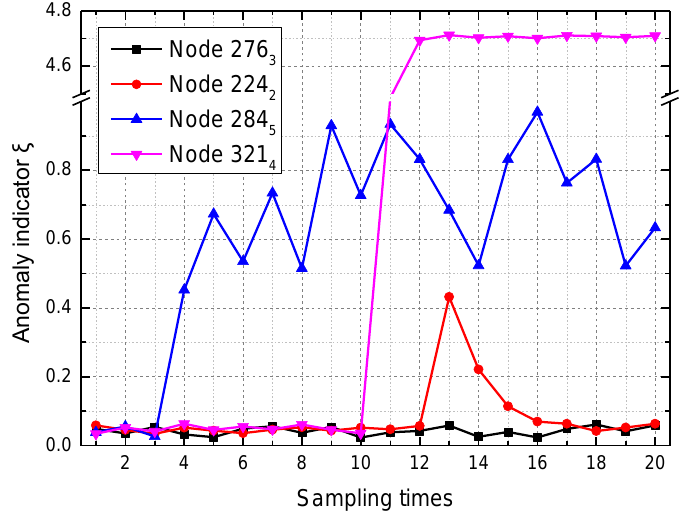
Figure 8. Anomaly indicator ξ of four sensor nodes in a short-term span. Sensors 2016 , 16 , x FOR PEER REVIEW